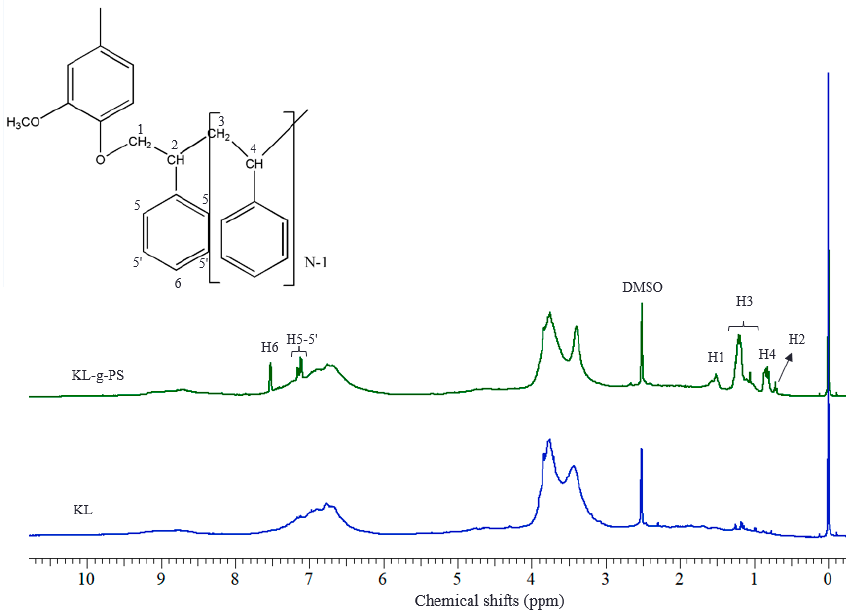
Figure 3. 1 H-nuclear magnetic resonance (NMR) spectrum of KL and KL- g -PS in dimethyl sulfoxide (DMSO).